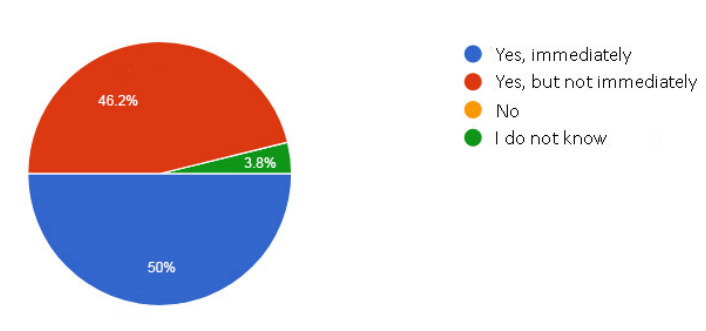
Figure 10. A total 96.2% of municipalities would not be against paying the increased purchase price of smart bins compared with conventional ones, considering the benefits that will result from its use.